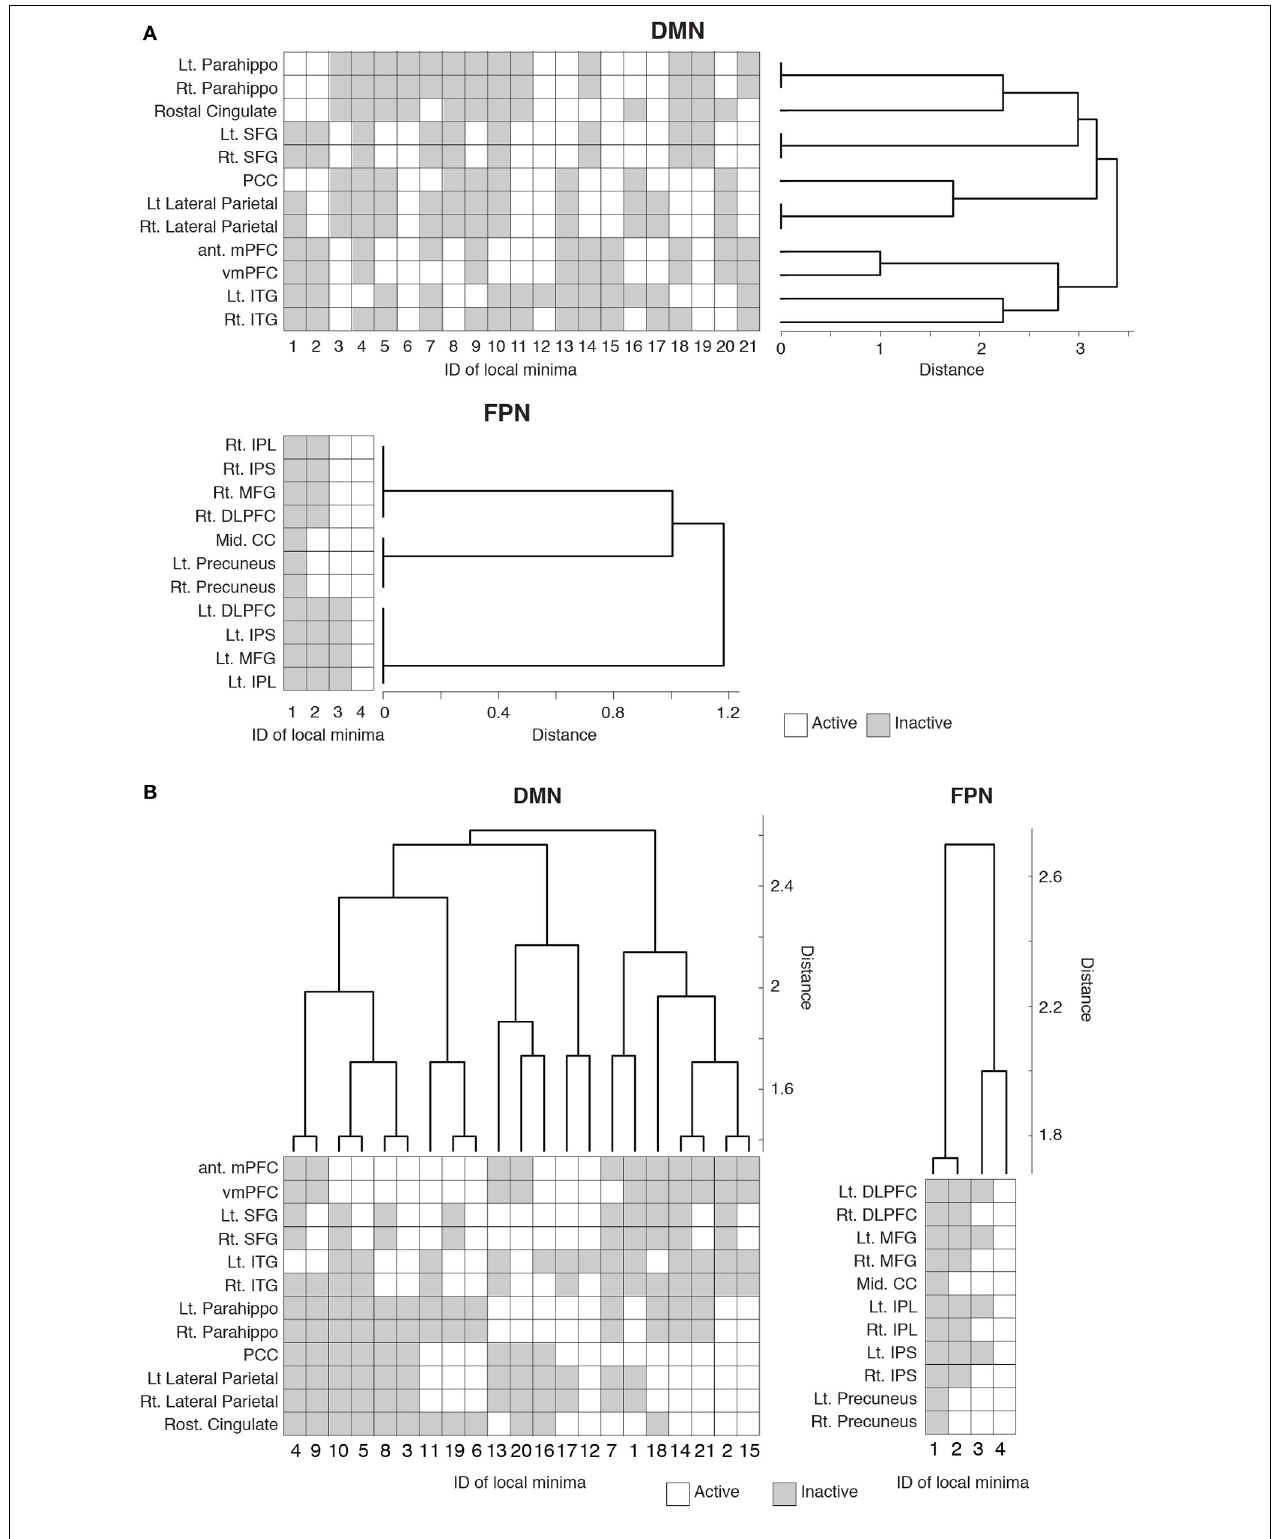
FIGURE 3 | Hierarchical clustering of the brain regions and local minima. Each row represents the activity pattern of a brain region in different local minima. Each column represents the activity pattern of a local minimum in different brain regions. (A) Dendrogram showing the